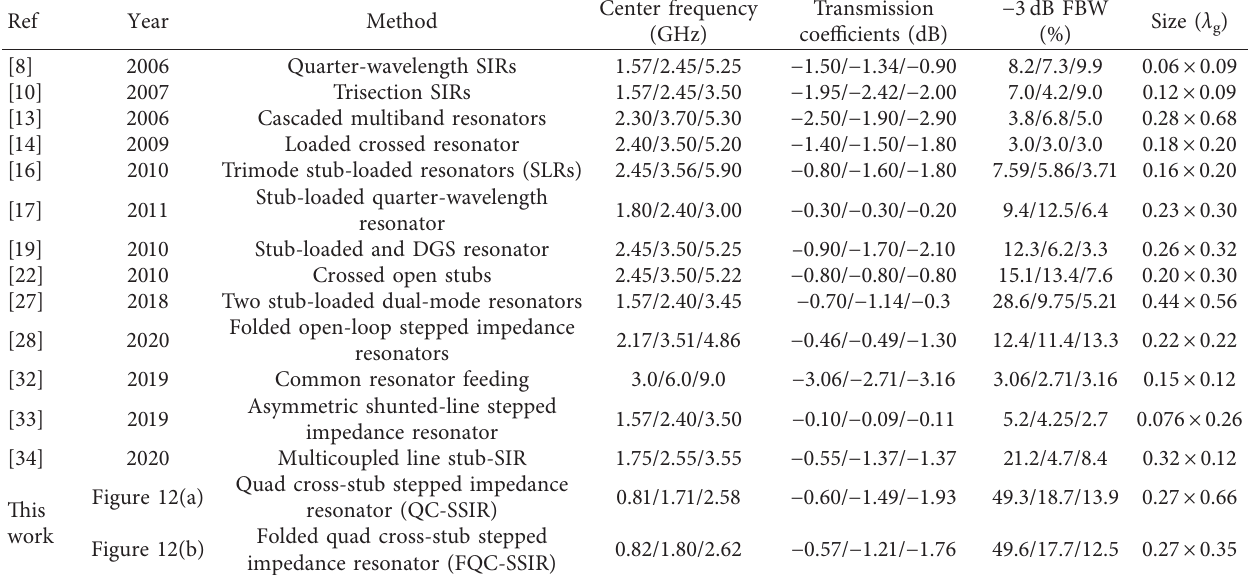
λ g is the guided wavelength on the substrate at the center frequency of the first